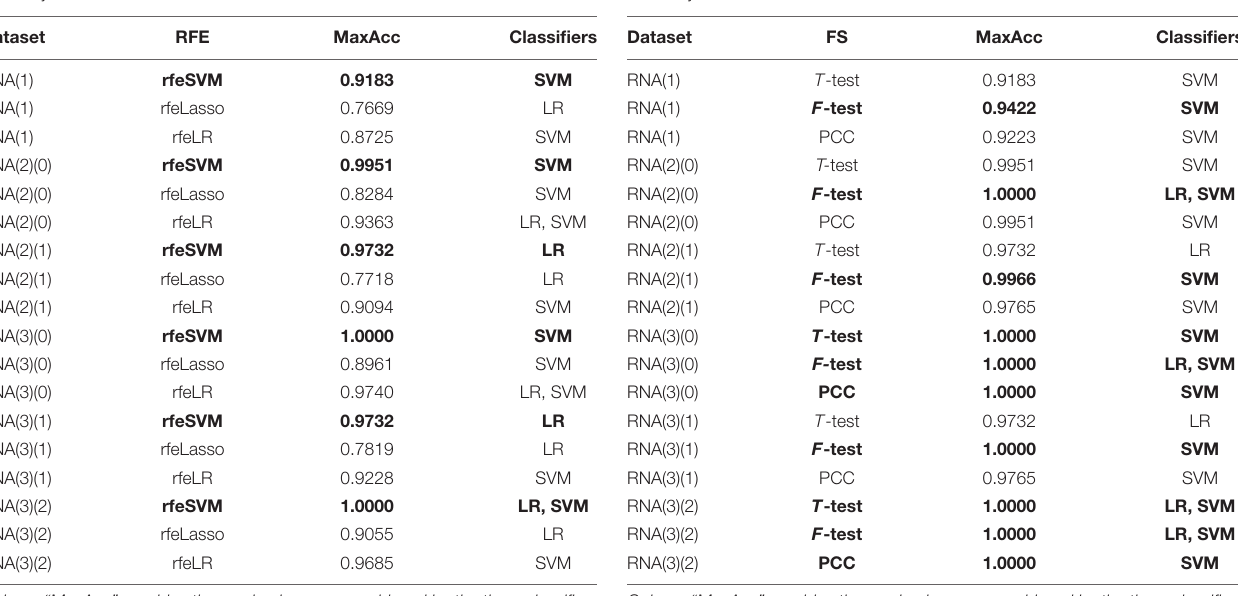
Frontiers in Genetics |